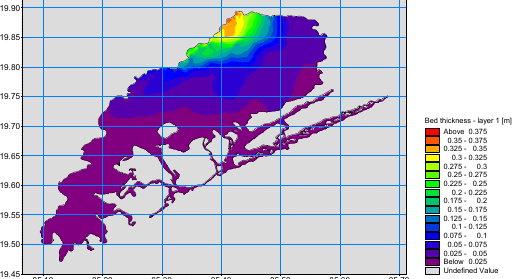
Figure 7b. Simulated spatial profile of Bed thickness-layer